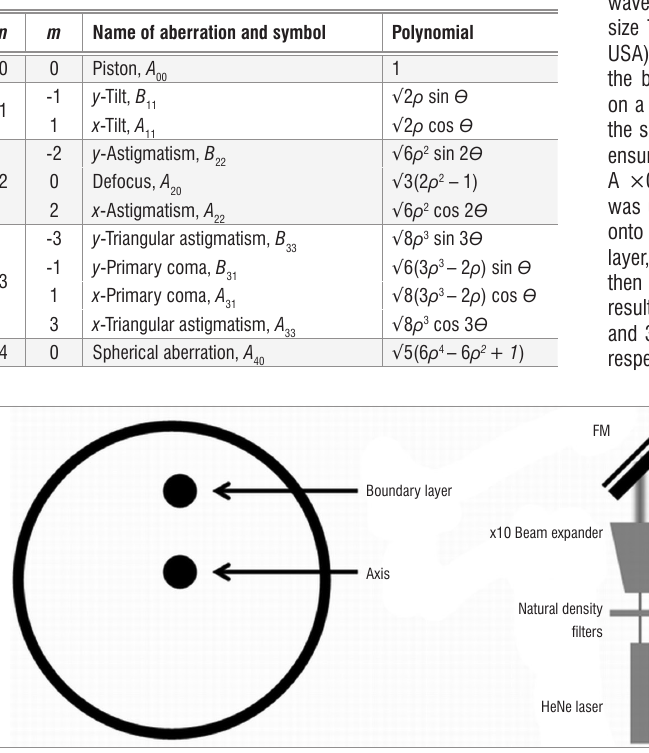
Figure 2: (a) A three-dimensional longitudinal density profile for the spinning pipe gas lens showing transverse sections at critical planes with two-dimensional profiles and (b) the transverse density profile at the centre of the spinning pipe gas lens. Zernike primary aberrations